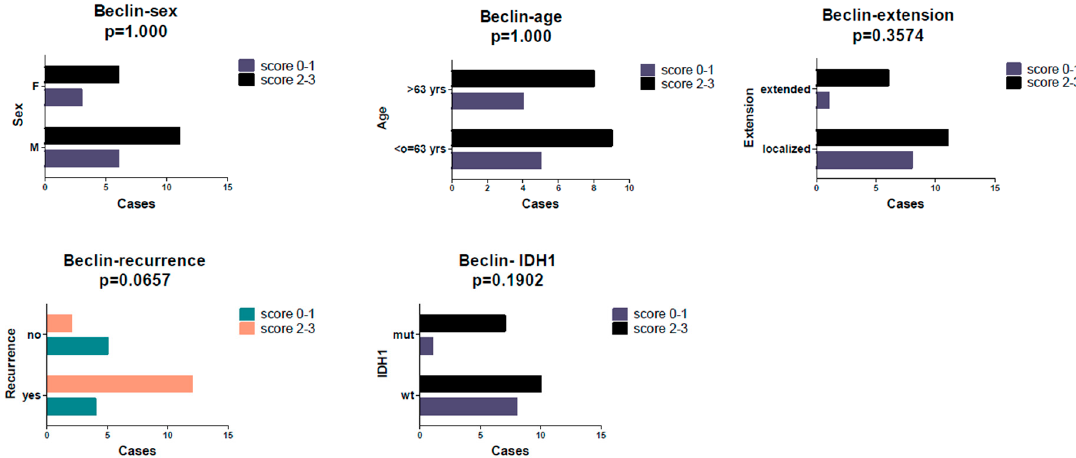
Figure 4. No statistically significant associations were found between Beclin immunoscore and clinicopathological features, but a slight tendency for a higher score in recurrent cases was detected ( p = 0.0657 ).